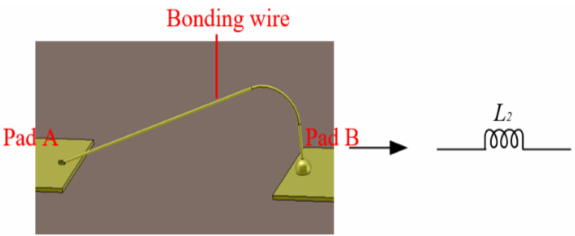
Figure 4. Equivalent connection impedance network of bonding area.